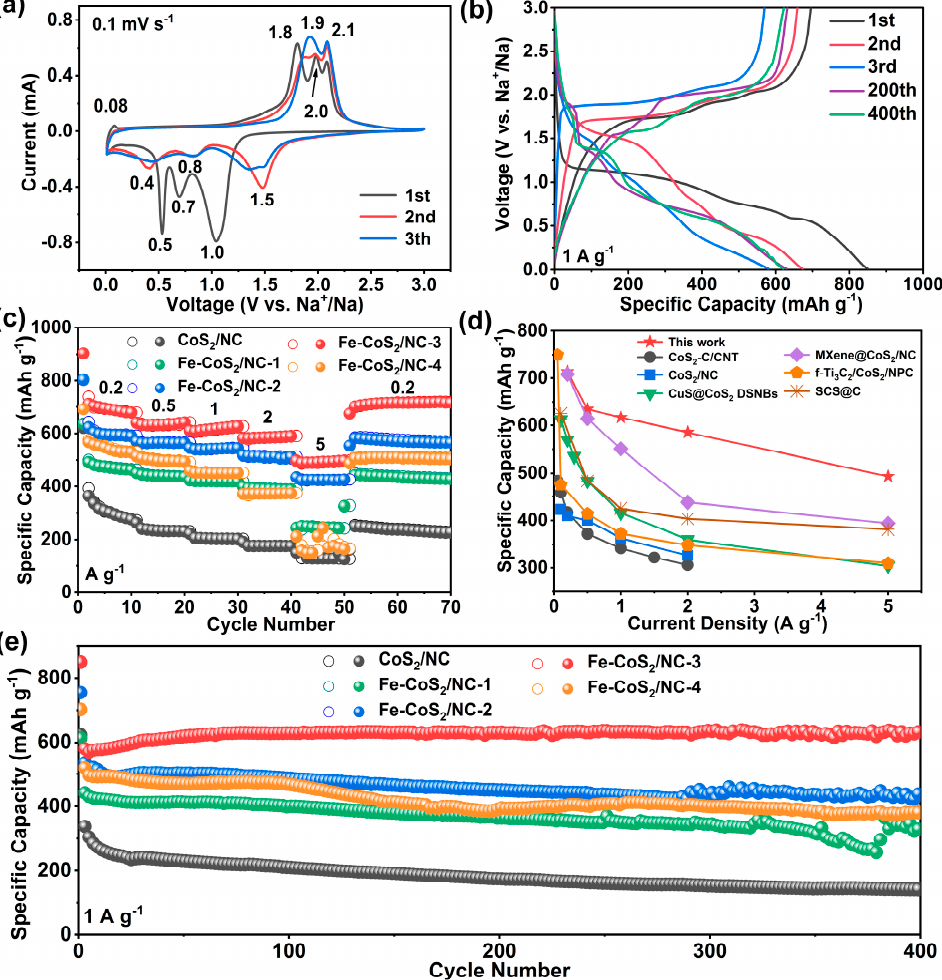
Figure 4. ( a ) CV curves of the Fe-CoS 2 /NC-3 electrode at 0.1 mV s − 1 . ( b ) GCD curves of the Fe-CoS 2 /NC-3 electrode at 1 A g − 1 , ( c ) comparison of the rate performance of Fe-CoS 2 /NC-3 with CoS 2 /NC, Fe-CoS 2 /NC-1, Fe-CoS 2 /NC-2, and Fe-CoS 2 /NC-4, ( d ) comparison of the rate capability with other CoS 2 -based electrodes as previously reported in the literature, ( e ) comparison of the long-term cycling performances of the electrodes at 1 A g − 1 .